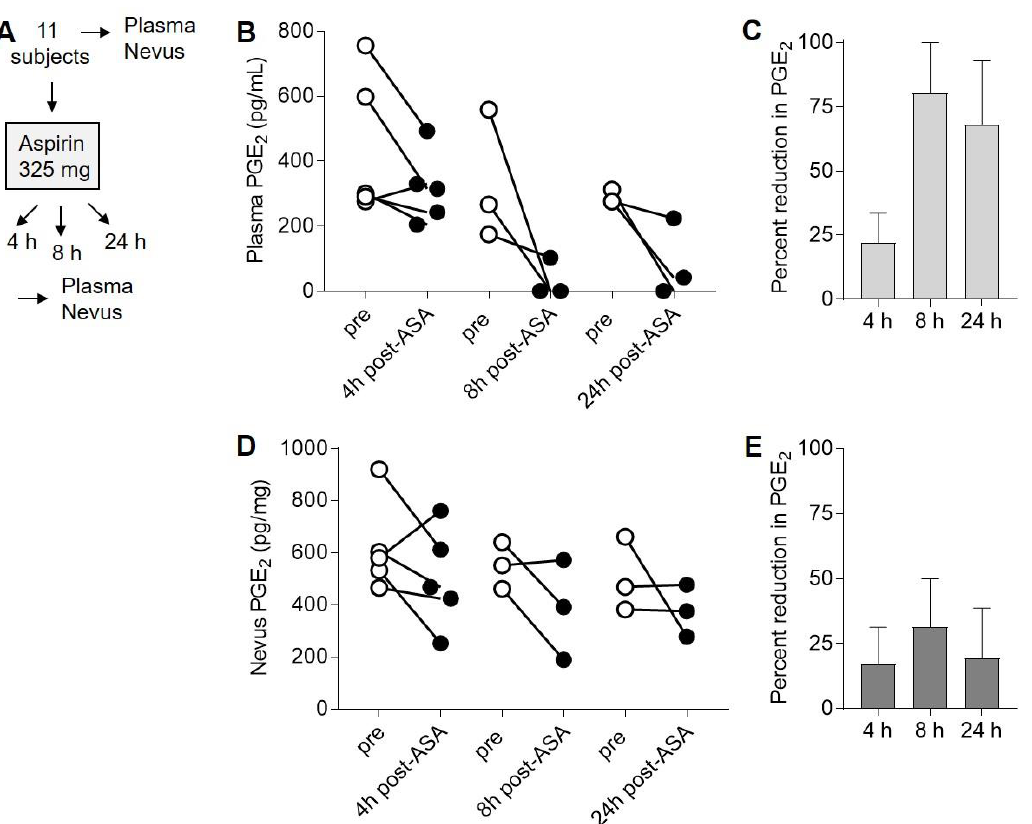
Figure 3. Suppression of prostaglandin E2 (PGE 2 ) in plasma and nevi following single dose of ASA. ( A ), Experimental design. Human subjects were each given a single 325 mg dose of ASA, and blood and nevus samples were obtained both before (pre) and either 4 (n = 5), 8 (n = 3), or 24 (n = 3) h later. ( B ), Plasma PGE 2 levels before (open circles) and after (filled circles) aspirin treatment. ( C ), Average percent reduction in plasma PGE 2 at each time point from ( B ). Error bars represent SEM. p = 0.09, ANOVA. ( D ), PGE 2 levels in nevi taken before (open circles) and after (filled circles) ASA treatment. ( E ), Average percent reduction in nevus PGE 2 at each time point from ( D ). Error bars represent SEM. p = 0.8, ANOVA. For the ANOVA analyses, the log ratio was first calculated for each subject, and then the log ratios were compared between groups.